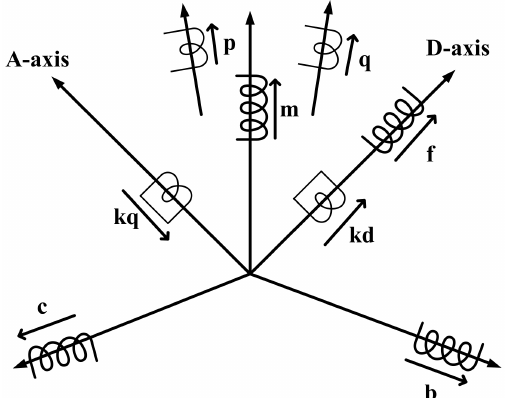
Figure 2. Internal schematic diagram of single-phase grounding fault winding of a hydro